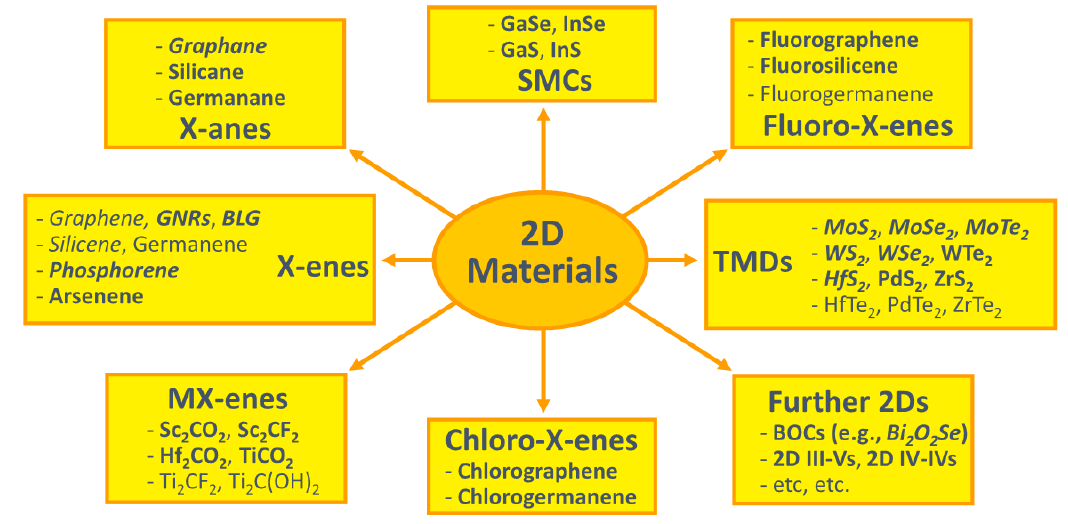
Figure 32. Drawing of different 2D materials [205].